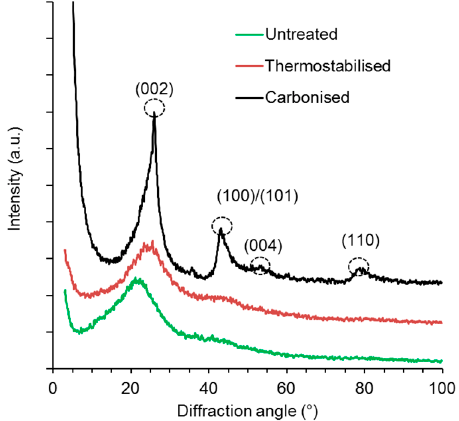
Figure 6. XRD patterns of organosolv lignin microparticles prior to and after thermostabilisation and carbonisation.